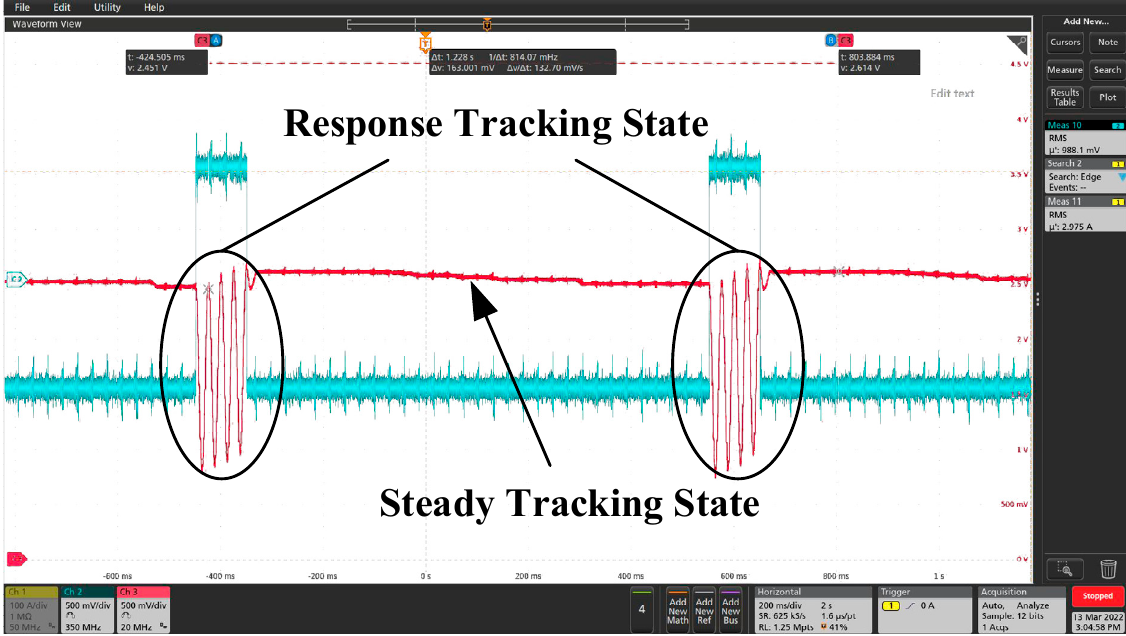
Figure 11. Displacement–time response curve under pulse excitation signal (pulse width: 200 ms).